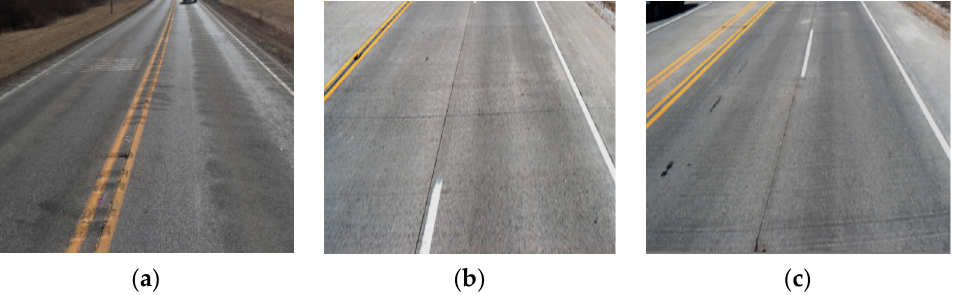
Figure 5. Location and trajectory of target domain dataset segments.